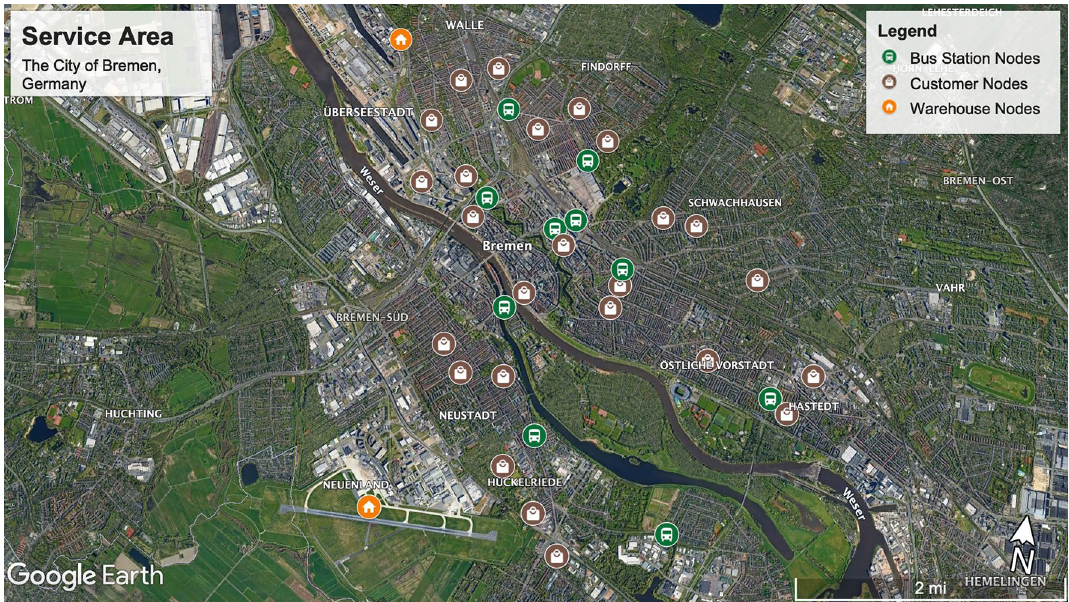
Figure 3. The service area representing the locations of public bus stations, warehouses, and customers in the city of Bremen, Germany, Google© Map (Aug,